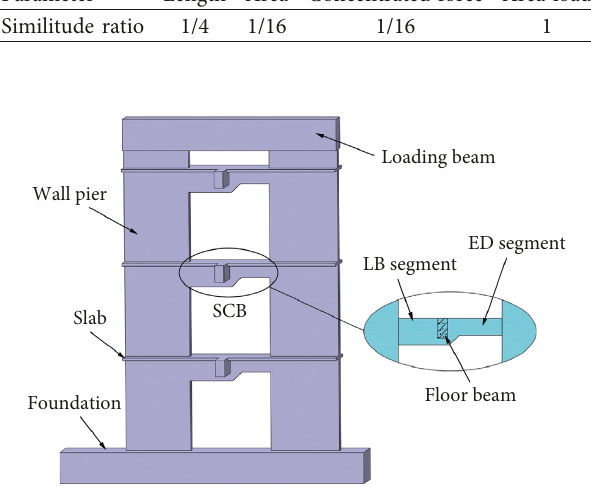
Figure 2: Overall illustration of the